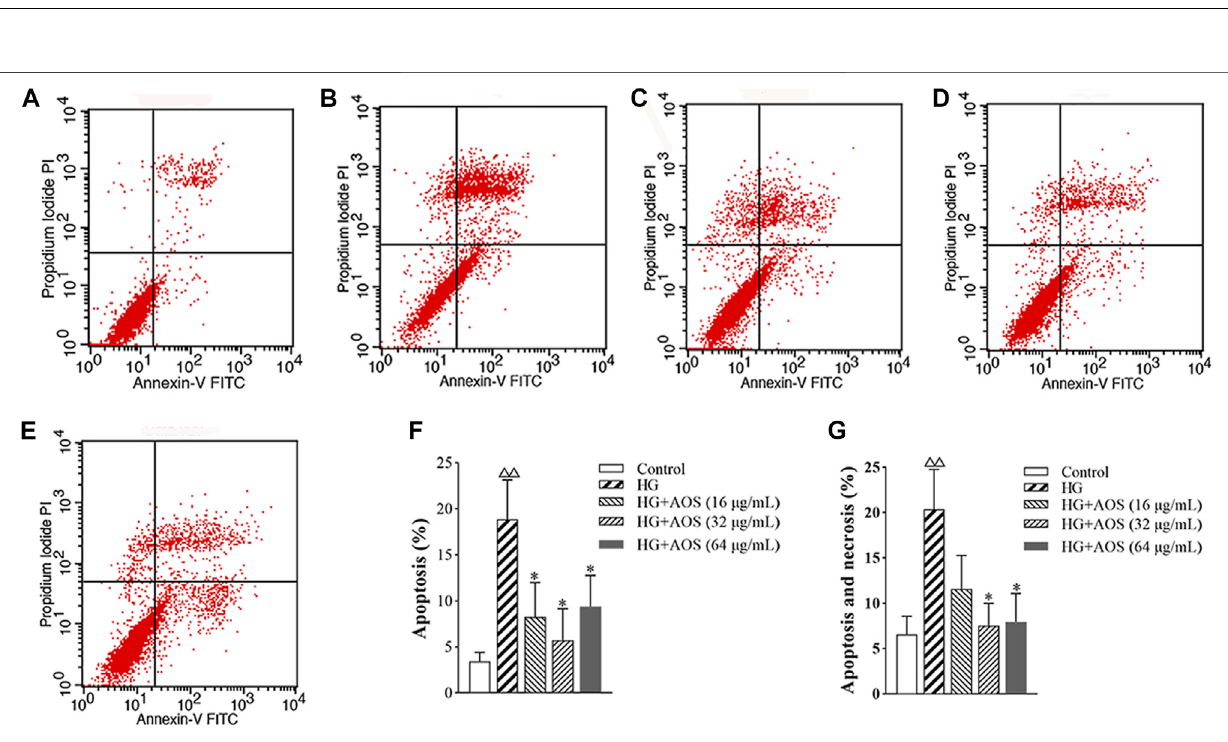
Frontiers in Pharmacology |